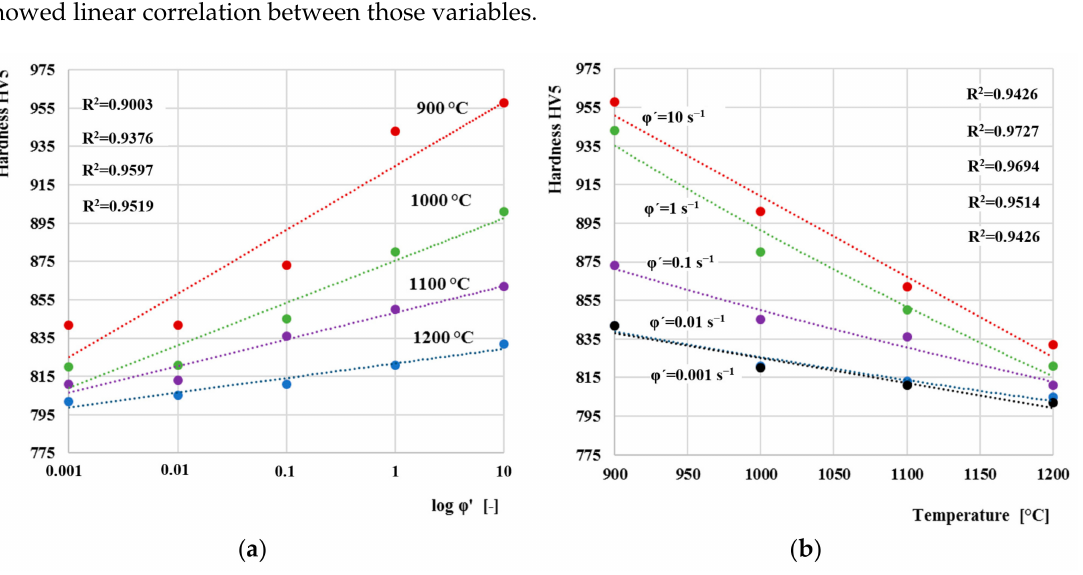
Figure 19. Influence of strain rate ( a ) and deformation temperature ( b ) on Vickers hardness (HV5) of AISI 4340 steel.